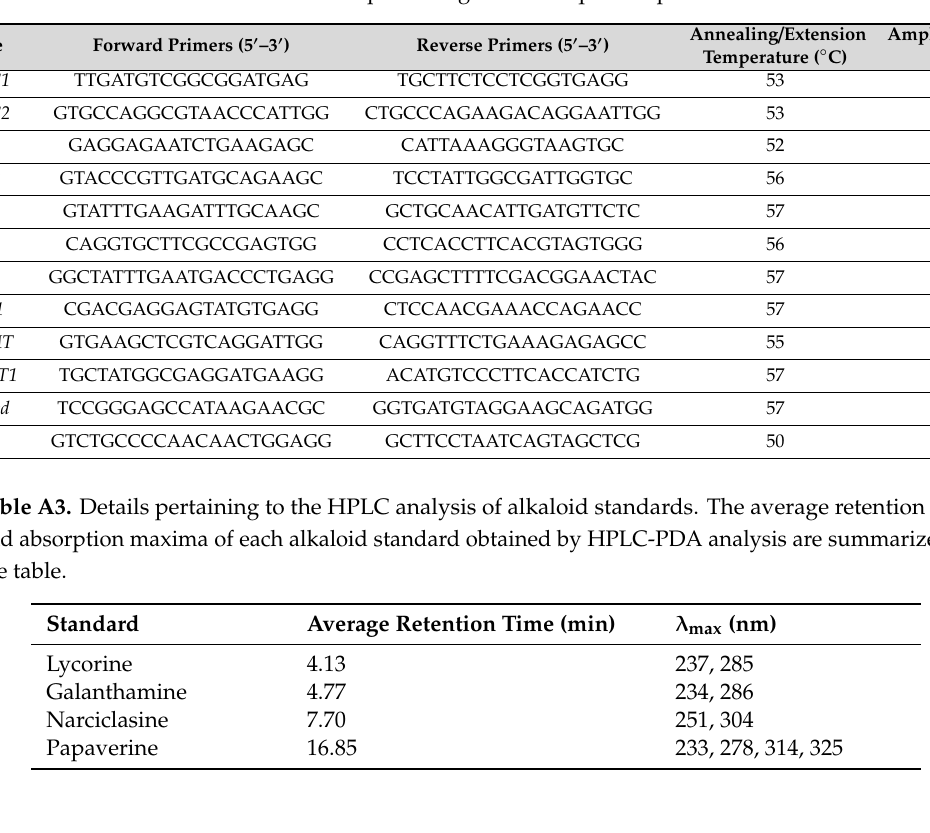
Table A2. Details pertaining to the RT-qPCR experiments.